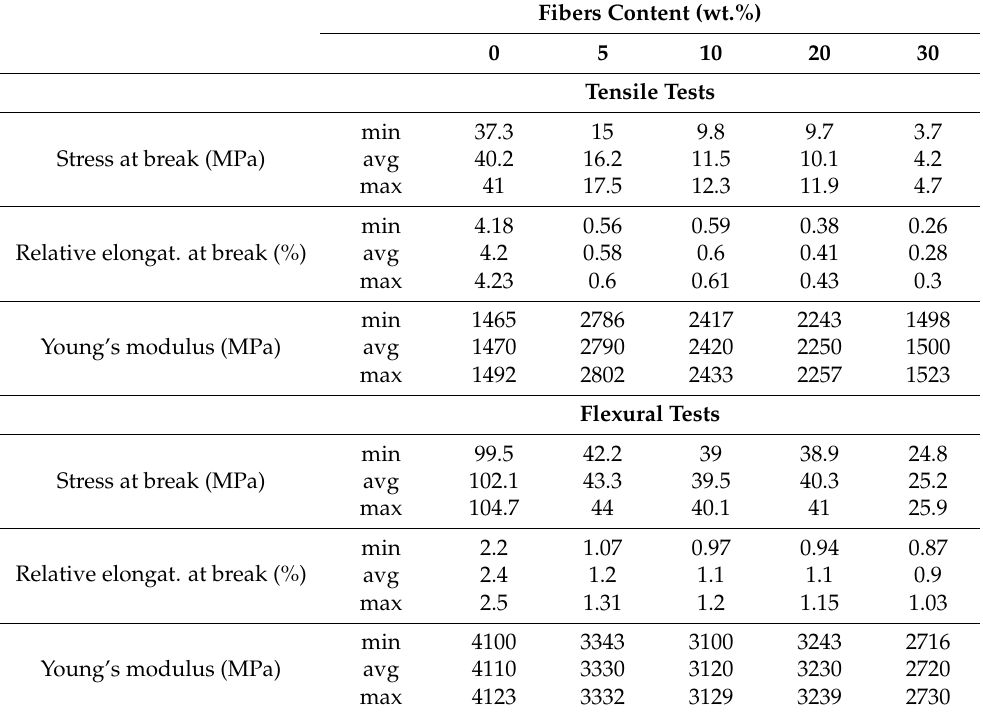
Table 5. Tensile and flexural strength data of the